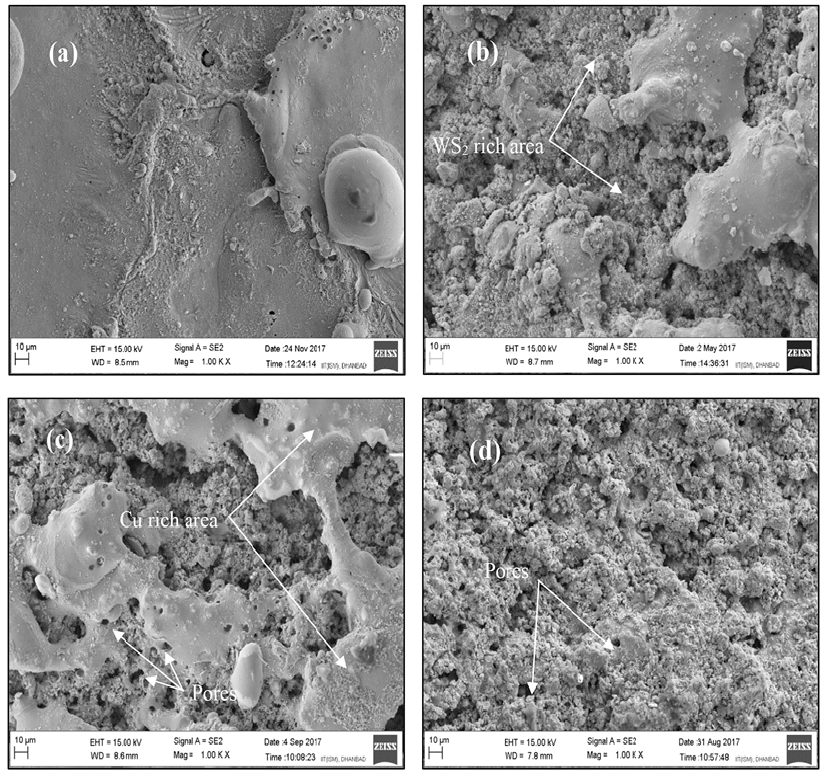
Figure 12. FESEM images of coating prepared at WS 2 :Cu ( a ) 0:100, ( b ) 40:60, ( c ) 50:50, and ( d ) WS 2 :Cu/60:40 [6].